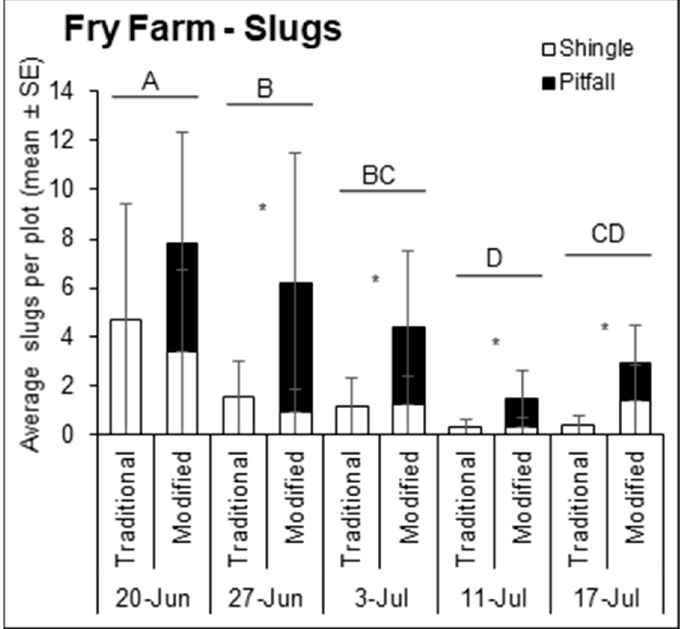
Figure 4. Average number of slugs sampled from under the traditional (left bar) and modified (right bar) traps for each sampling date in 2019 at Fry Farm in Wooster, OH, USA. Data from the modified trap are broken down into components (shingle, white vs. pitfall, black). Uppercase letters represent significant differences ( p < 0.05) from multiple comparisons analyses comparing total slugs per plot over time. Asterisks indicate significant differences ( p < 0.05) in the number of slugs caught by the traditional and modified traps for that sampling date.